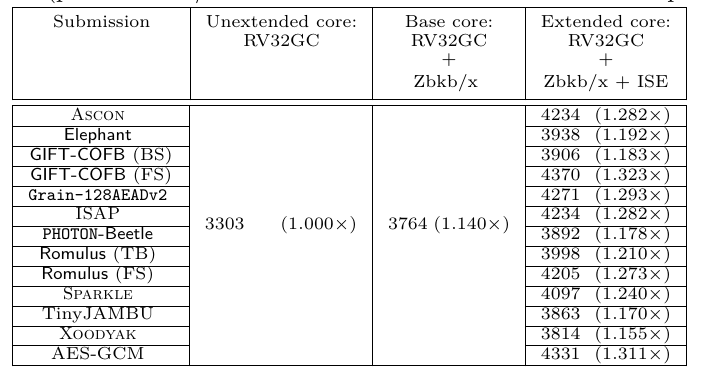
Table 2: Hardware-oriented evaluation, i.e., realisation of each ISE design: area measured in FPGA LUTs (plus increase/decrease factor versus unextended core in parentheses).